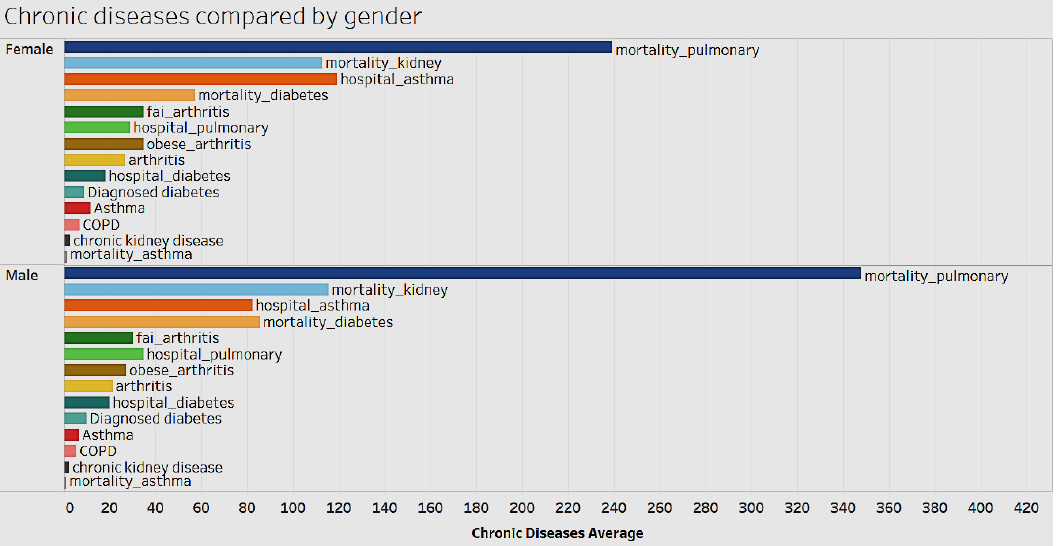
Figure 6. Chronic condition by gender.